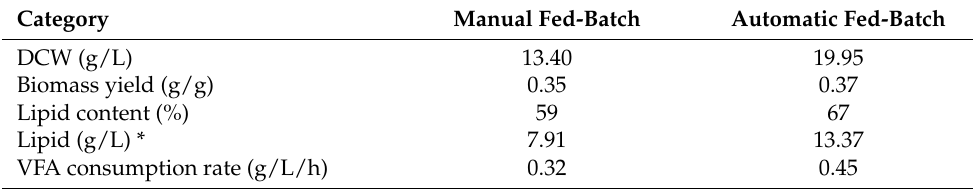
Table 1. Comparison of manual and automatic fed-batch cultivation.